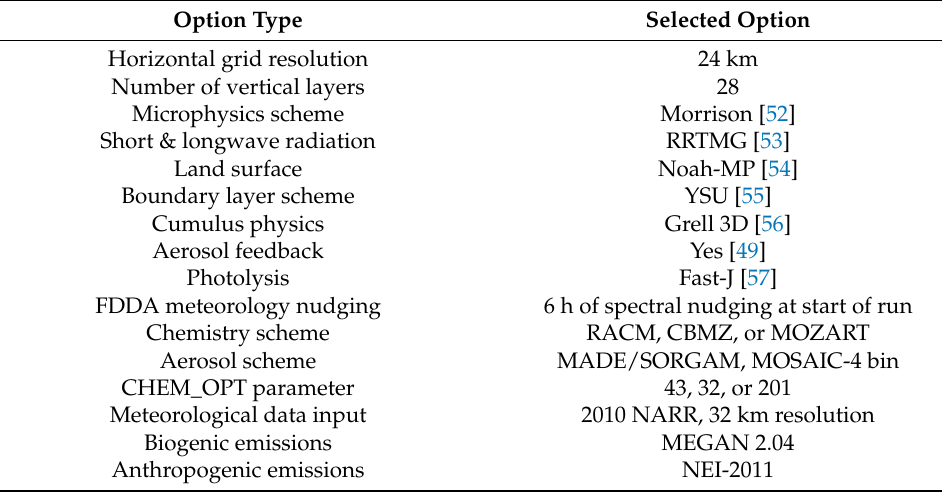
Table 1. Physical and chemical parameterizations used in WRF-Chem model